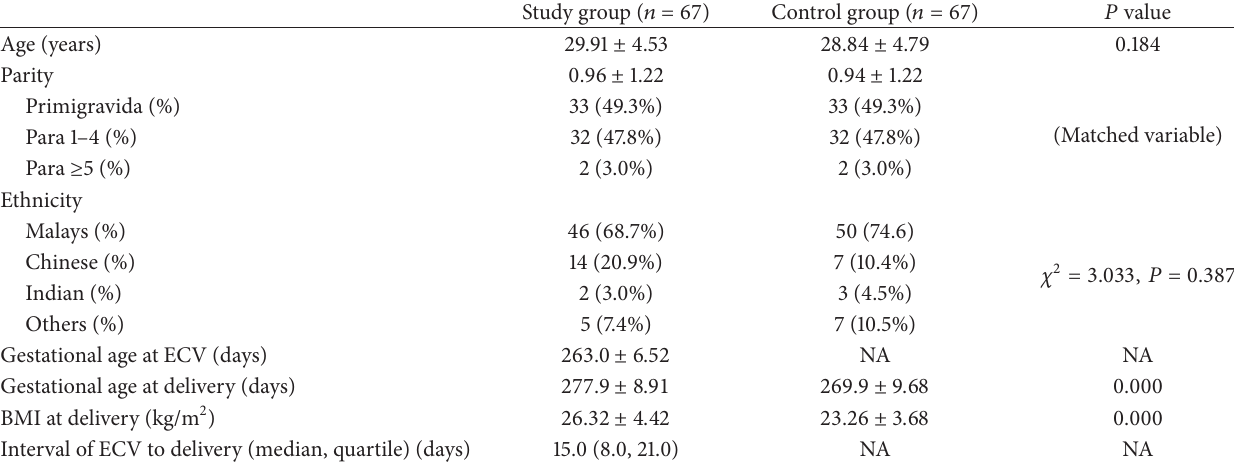
Table 3: Maternal characteristics of the study group (successful external cephalic version) and control group (spontaneous cephalic